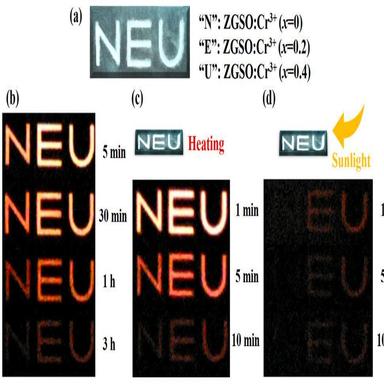
Appearance of the designed logo under daylight (a), and the afterglow images based on various treatments: (b) after removal of 254-nm radiation (high power) for 10 min, (c) after heating at 130 ◦C for 90 s after the disappearance of afterglow signal. (d) is afterglow images after removal of natural light excitation, when the heating afterglow signal disappeared. The afterglow signals were obtained by a night vision device, and the color is false color. (For interpretation of the references to color in this